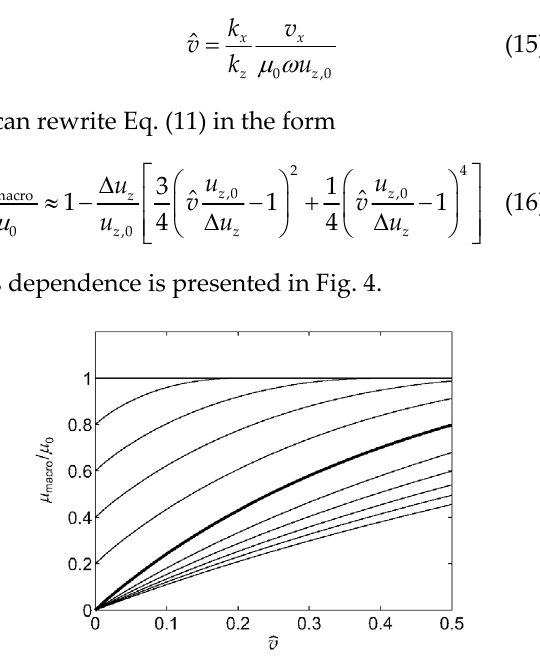
Fig. 4 Dependence of the normalized coefficient of friction on the dimensionless velocity (15): The horizontal line at the constant value 1 corresponds to sliding friction without oscillation. When the oscillation amplitude increases, the static force of friction (at zero velocity) decreases until it vanishes (bold line). This trend is shown in the upper part of the plot for amplitudes / 0.2, 0.4, 0.6, 0.8, 1.0 (from top to bottom). Further ,0 z increase of the oscillation amplitude leads to loss of contact during a part of the oscillation period. In this range of oscillation amplitudes, the static friction force remains zero, and the slope of the dependency decreases with increasing oscillation amplitude. This is shown in the lower part of the plot for